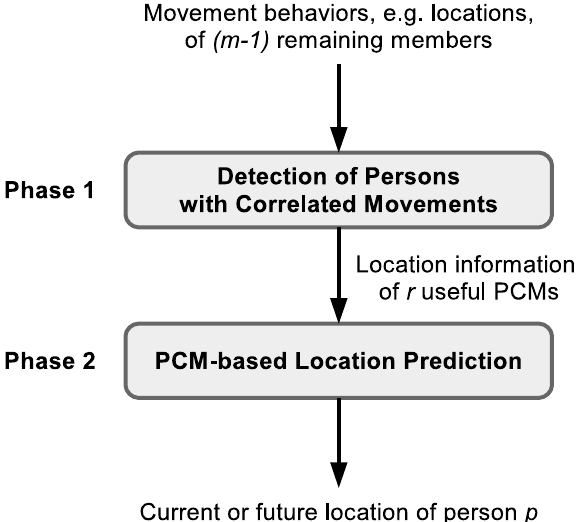
Figure 1. The proposed framework for predicting the current or future location of person p